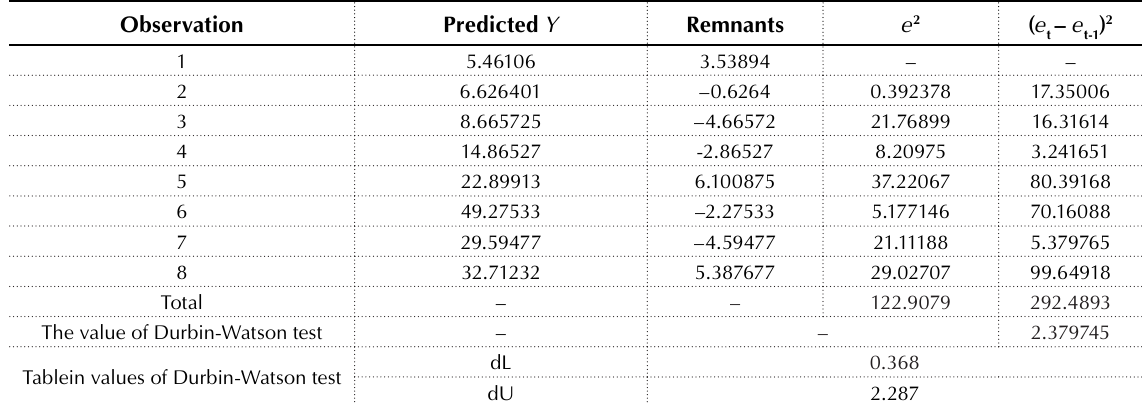
Tablein values of Durbin-Watson test